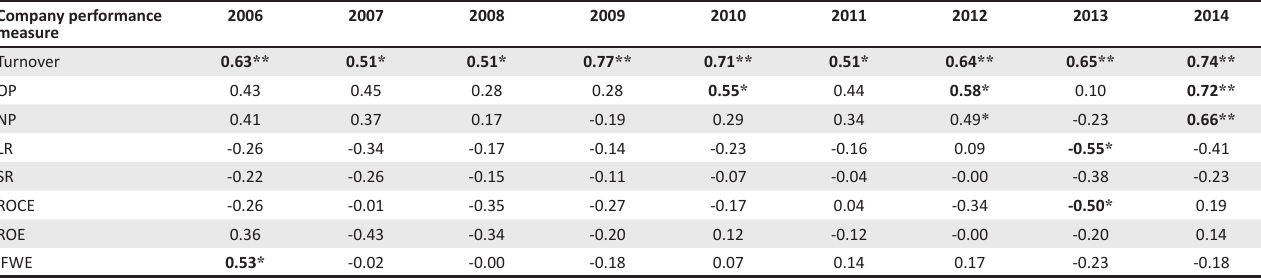
TABLE 3: Correlation: Fixed pay and state-owned companies’ performance ( n = 18 per year). Company performance measure